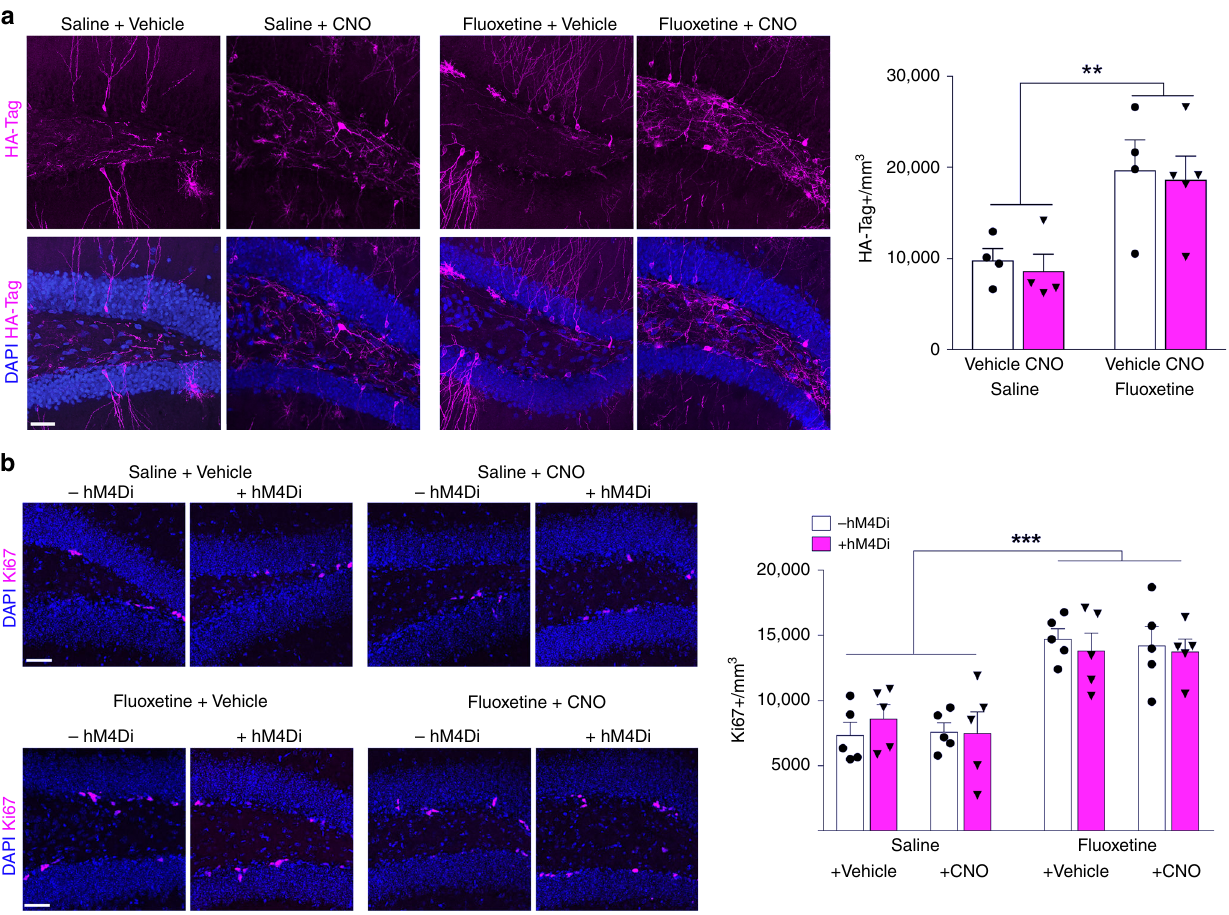
Fig. 2 CNO silencing does not alter the increase in neurogenesis after fl uoxetine treatment. a Representative images and quanti fi cation of HA-Tag + dentate gyrus cells (By two-way ANOVA: Fluoxetine F 1,13 = 16.15, ** P = 0.0015; CNO F 1,13 = 0.2021, P = 0.660; Interaction F 1,13 = 0.0009, P = 0.976). b Representative images and quanti fi cation of ki67-positive dentate gyrus cells (by three-way ANOVA: Fluoxetine F 1,32 = 59.52, *** P < 0.0001; hM4Di F = 0.130, P = 0.721; CNO F = 0.143, P = 0.708; hM4Di*CNO F = 0.001, P = 0.980). Data are presented as means ± s.e.m. Scale bars 50 μ 1,32 1,32 1,32